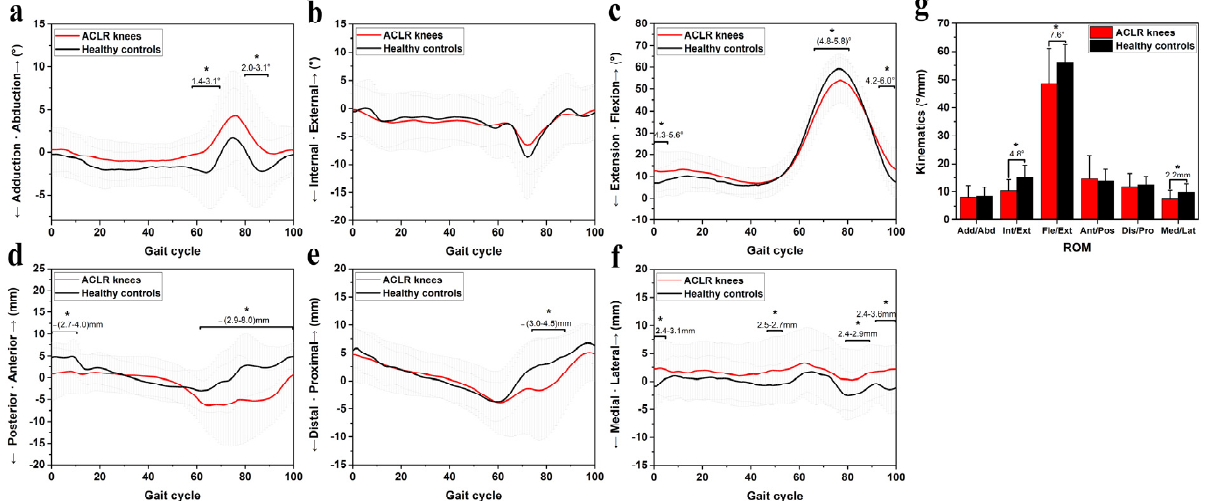
Figure 4. Chart of knee kinematics during level walking in ACLR knees. ( a – c ) The comparisions of angular parameters between ACLR knees and healthy controls; ( d – f ) The comparision of translational parameters between ACLR knees and healthy controls; ( g ) The comparisions of range of motionis of knee kinematics between ACLR knees and healthy controls. * Indicates that significant alterations ( p < 0.05) were found between ACLR knees and healthy controls. The numbers below the symbols represent the magnitudes of kinematics differences between the groups.